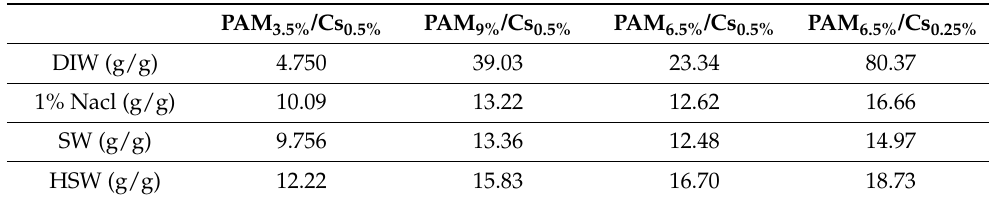
Table 2. Equilibrium swelling ratios of PAM/Cs in different salinity media.